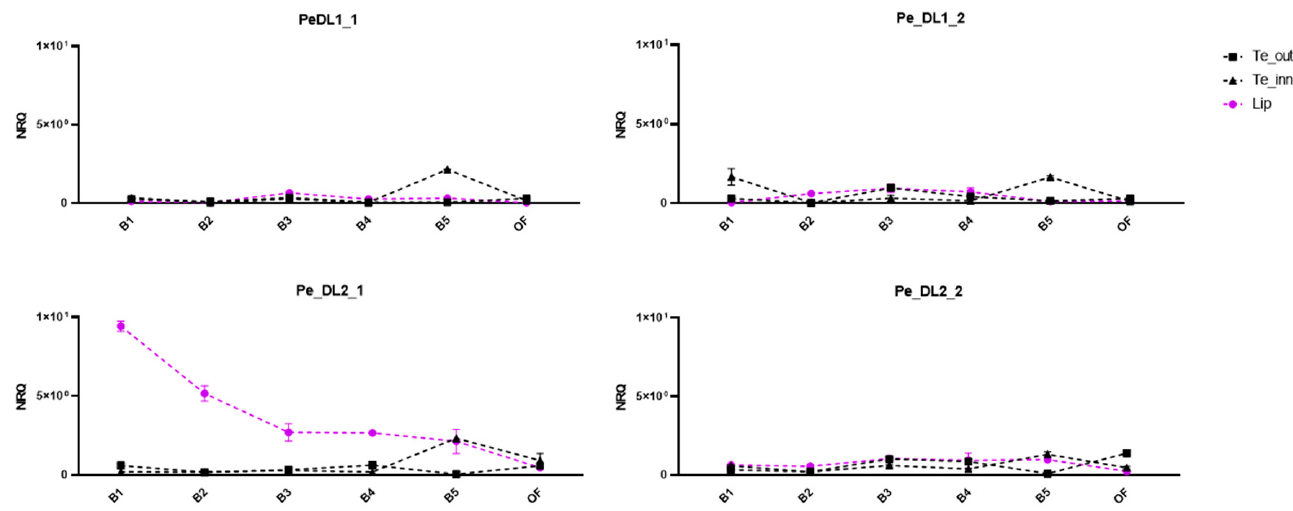
Figure 4. Relative expression of the different isoforms of the PeDL1 and PeDL2 genes in the perianth of the wild-type P. aphrodite at different developmental stages. The expression is reported as normalized relative quantity (NRQ). The bars represent the SEM of the biological and technical replicates. Bud size of the developmental stages: B1 (0.5–1 cm), B2 (1–1.5 cm), B3 (1.5–2 cm), B4 (2–2.5 cm), B5 (2.5–3 cm), OF (open flower). Te_out, outer tepals; Te_inn, lateral inner tepals.